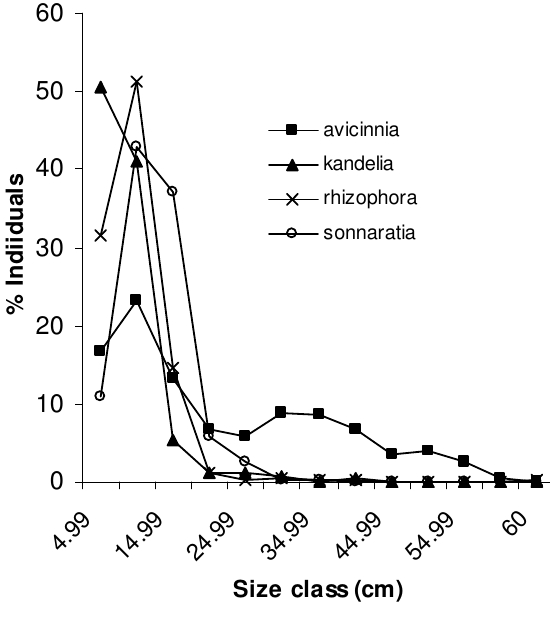
Fig. 3. Distribution of individuals in various size classes different from all species (KS test, p>0.05). Other species did not show significant difference among themselves (KS test NS). There were 339 stems (30.9%) that had multiple stems. Population of Avicinnia officinalis had much